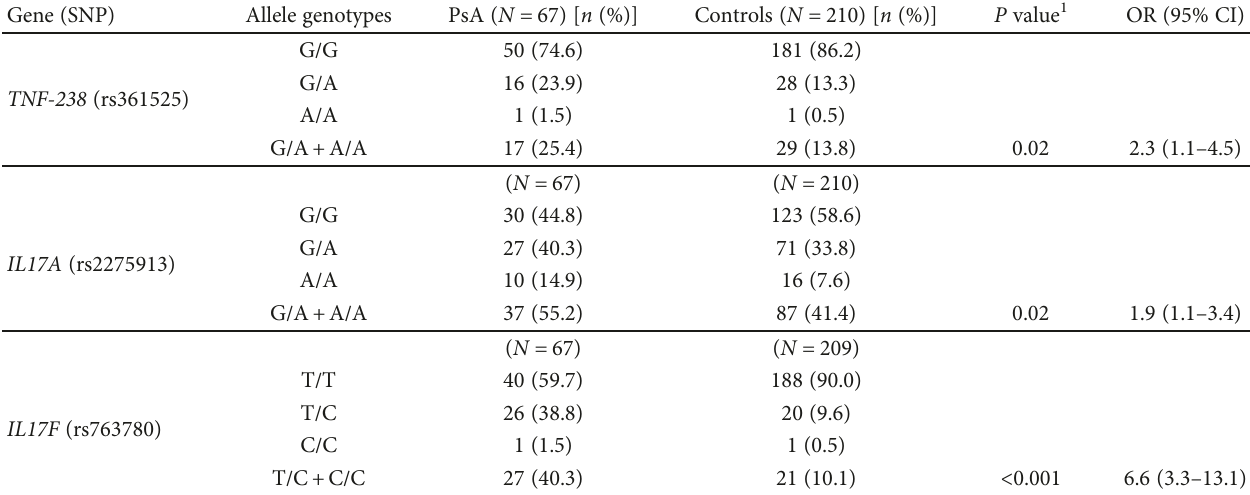
Table 5: Association of TNF -238, IL17A , and IL17F with the risk of PsA, strati fi ed by gender and HLA-B27 marker. Gene